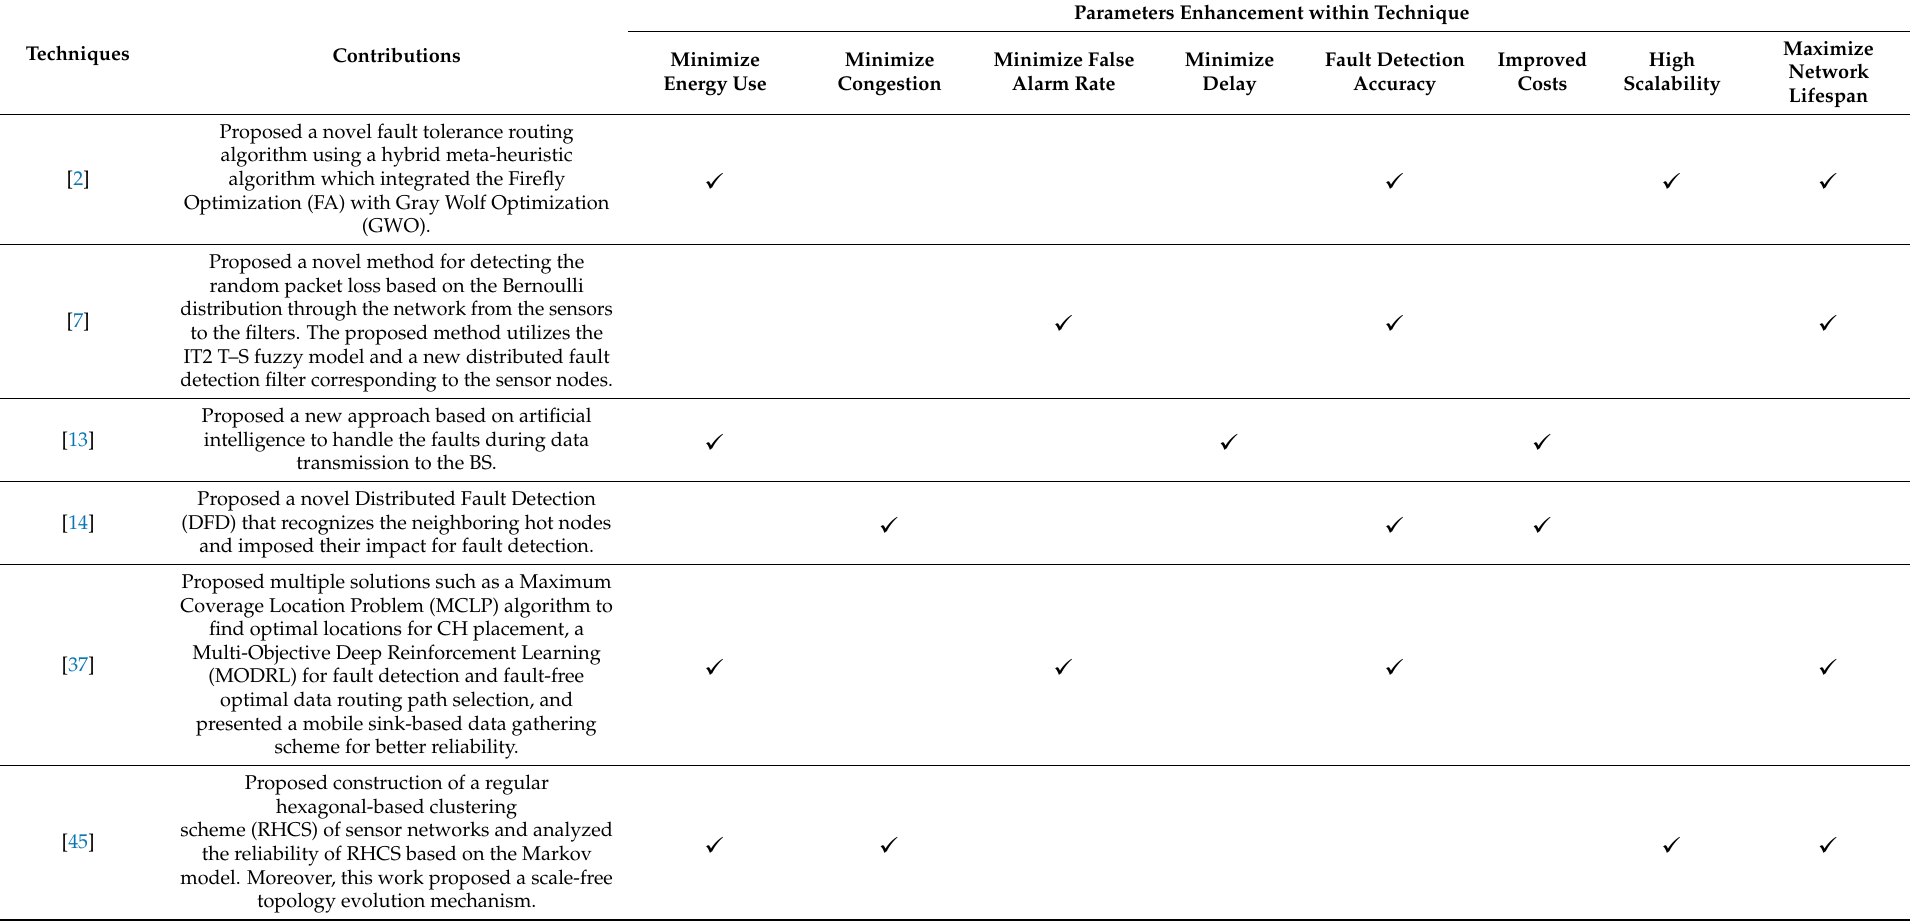
Table A1. Analysis and Classification of Fault Tolerance Management Structures. Table 1. Surveys on Fault-Tolerant in WSNs.